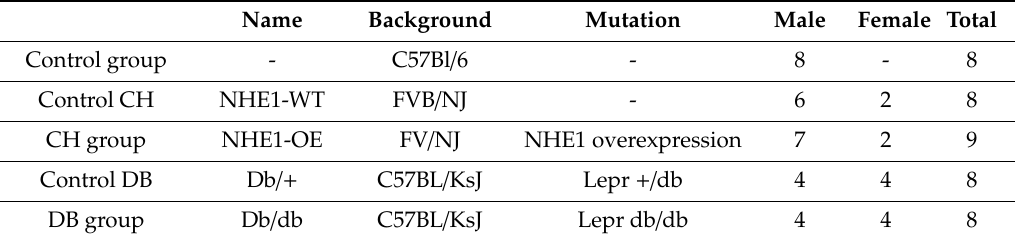
Table 3. Summary of the genetic profile of each selected group of animals regarding background, mutation and sex (see